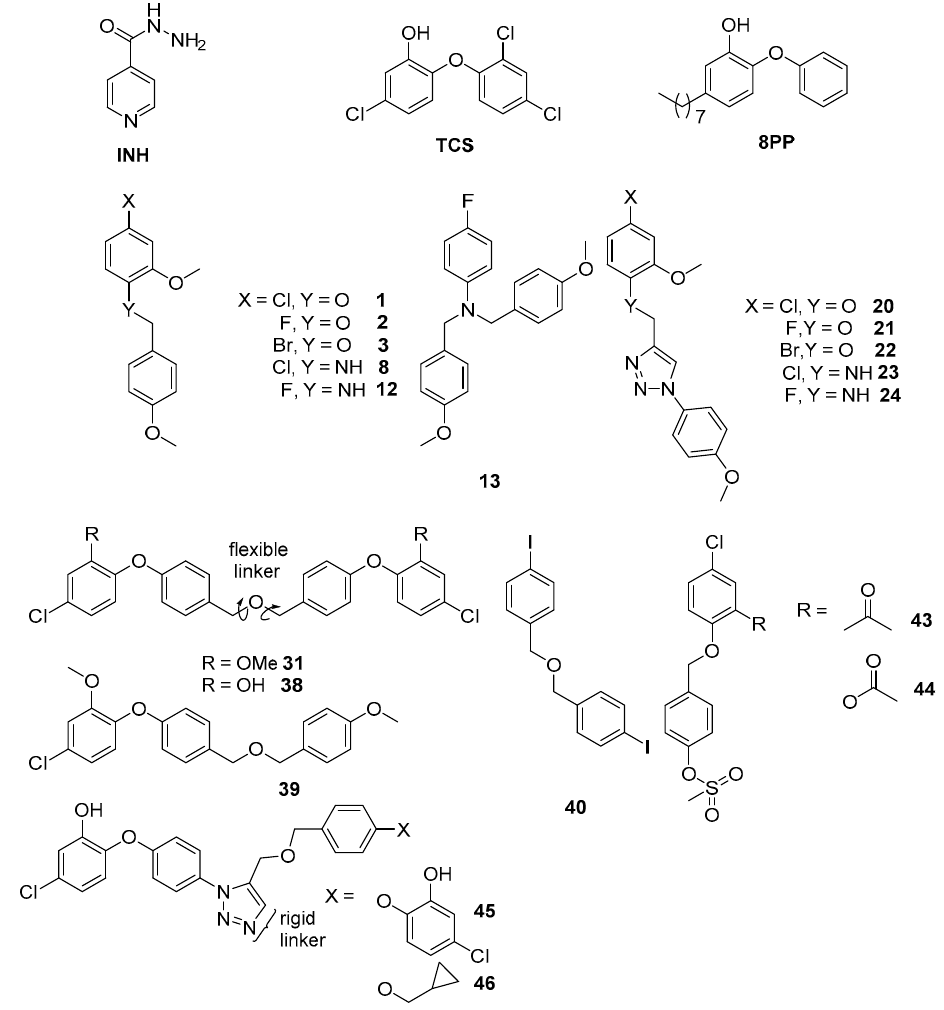
Figure 4. Compounds that were evaluated for biological activity together with compounds 45 and 46 from our previous study on a related series of triazole-linked di -triclosan analogues (47) and compound 8PP that is one of the most potent triclosan derivatives reported to date (IC 50 5.0 ± 0.3 nM; ( M. tuberculosis H37 RV )) [28].